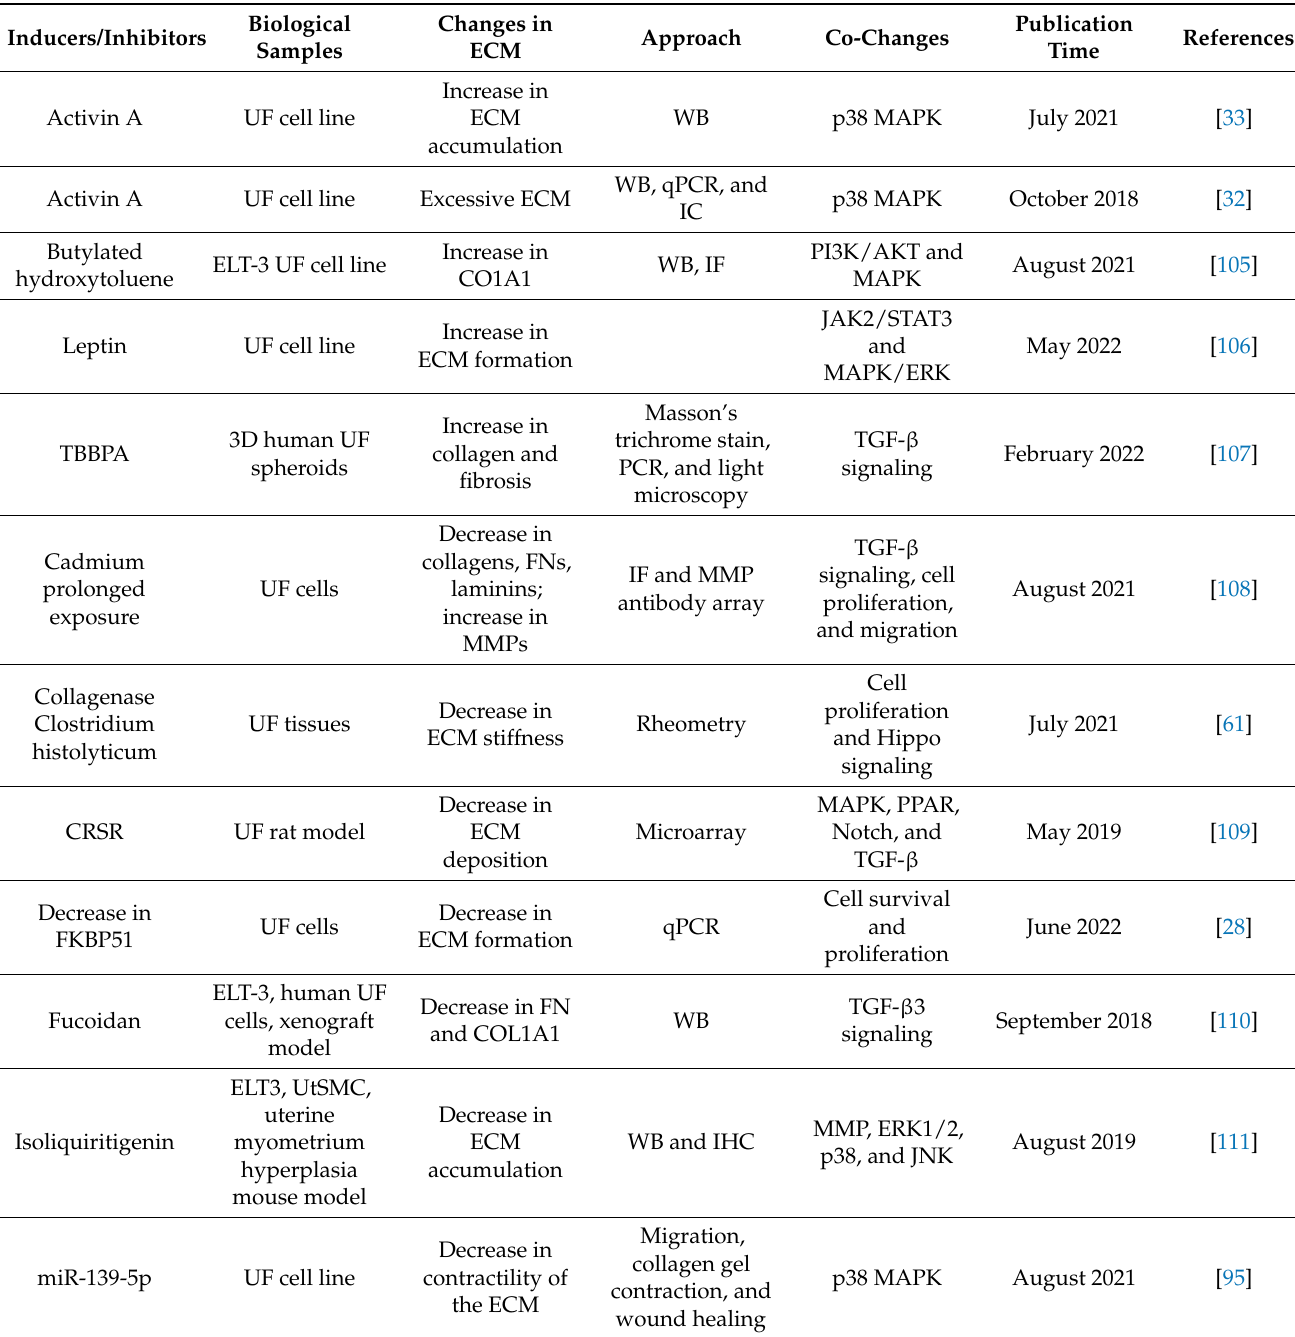
Table 1. Summarized ECM research in uterine fibroids since